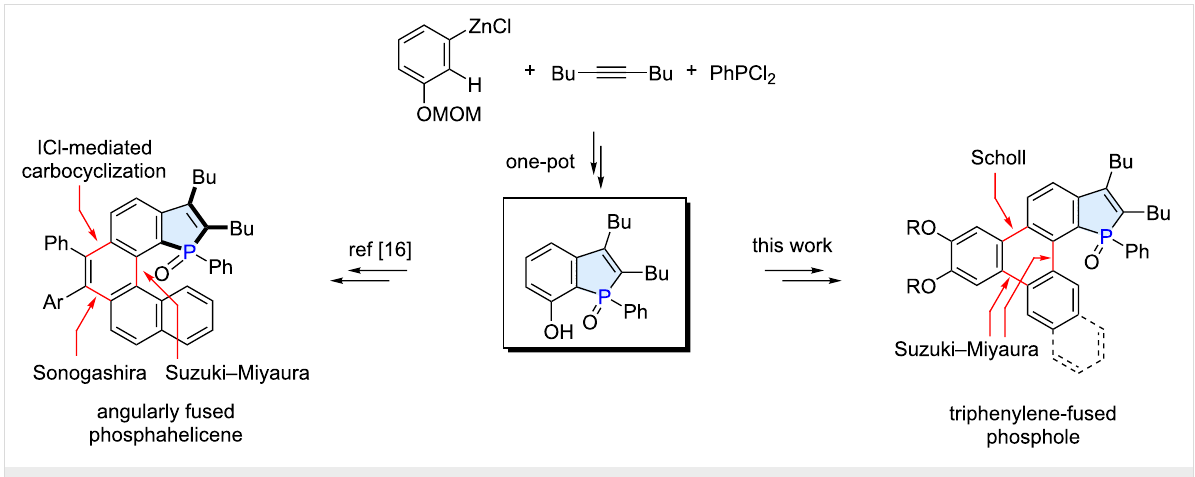
Scheme 1: Syntheses of PAH-fused phospholes featuring a 7-hydroxybenzo[ b ]phosphole as a key